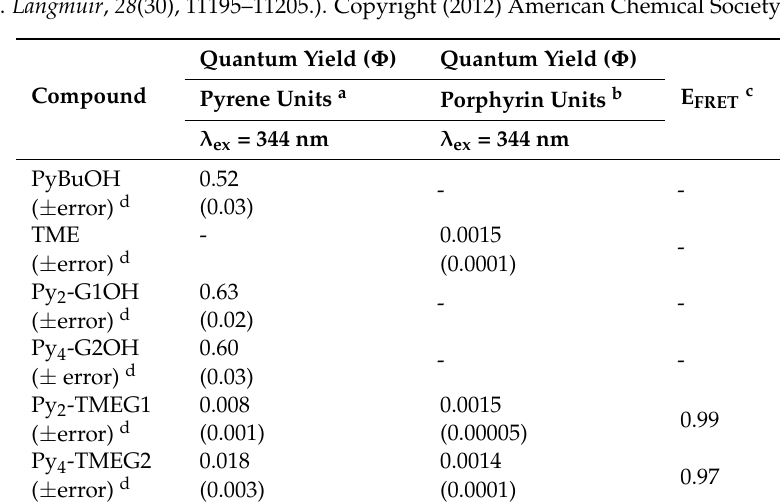
Table 1. Quantum yields and FRET efficiency for pyrene-labelled dendrons and pyrene dendronized porphyrins. Reprinted with permission from (Zaragoza-Gal á n, G., Fowler, M.A., Duhamel, J., Rein, R., Solladi é , N., & Rivera, E. (2012). Synthesis and Characterization of Novel